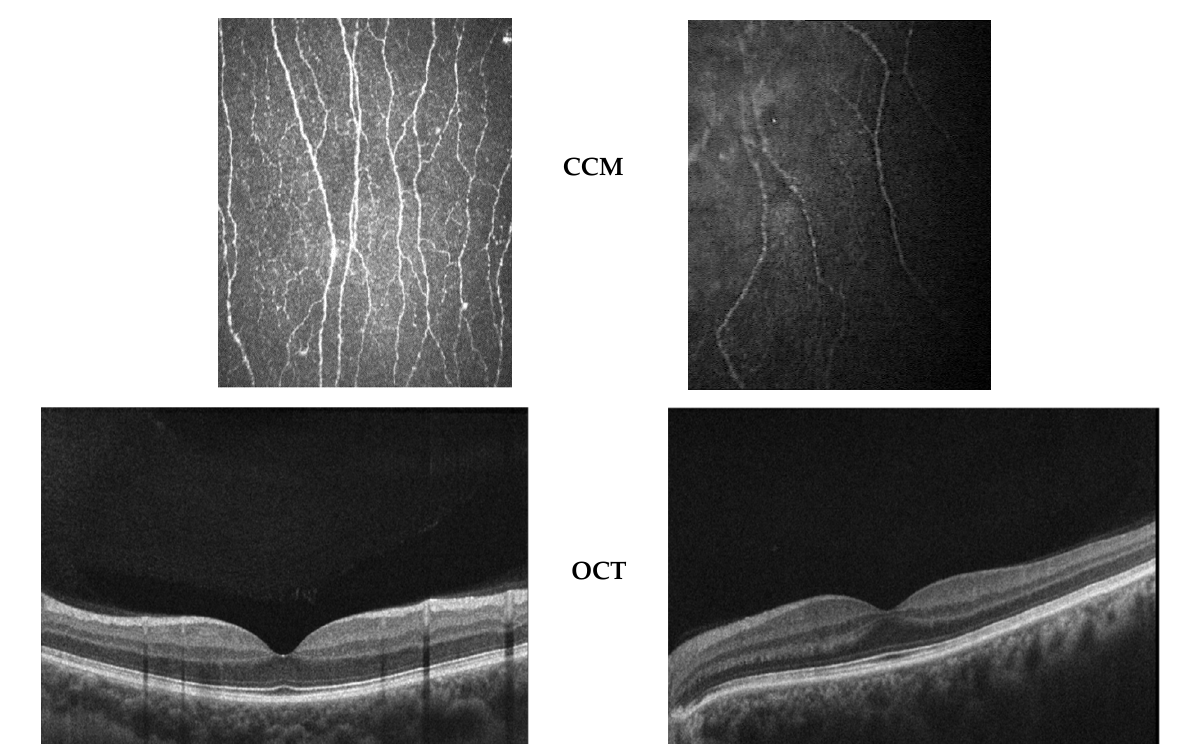
Figure 1. ERGs, CCM, and OCT of a healthy patient vs. an hATTR patient. Top to bottom: mixed Electroretinogram (ERG), photopic ERG, Corneal Confocal Microscopy (CCM), OCT B scan of a normal 43 year old control ( A ) and a 54 years old hATTR patient ( B ) RP. ( A ) shows normal ERG parameters, as well as normal nervous corneal plexus. OCT scan reveals a preserved morphology and reflectivity of all retinal layers, with a mean ONL thickness of 84 microns. ( B ) shows reduced ERG b-wave amplitudes and a poorly represented corneal nervous plexus. No alterations of retinal morphology and reflectivity are observed on OCT scan. Mean ONL thickness is reduced in comparison to normal control (61